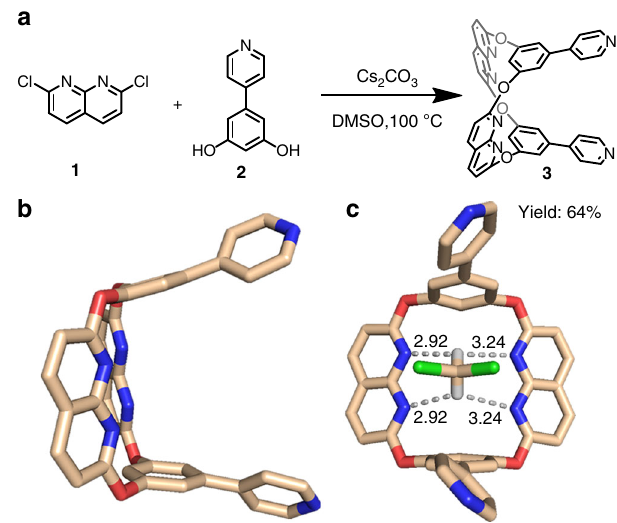
Fig. 1 Synthesis and single-crystal structures of ligand 3. a Synthesis of endo-functionalized molecular tweezer 3 . b Side view of the solid-state structure of 3 : (hydrogen atoms are omitted for clarity). c Multiple C – H···N hydrogen bonds between the H atoms of DCM and the N atoms of the naphthyridyl groups: C – H···N distances